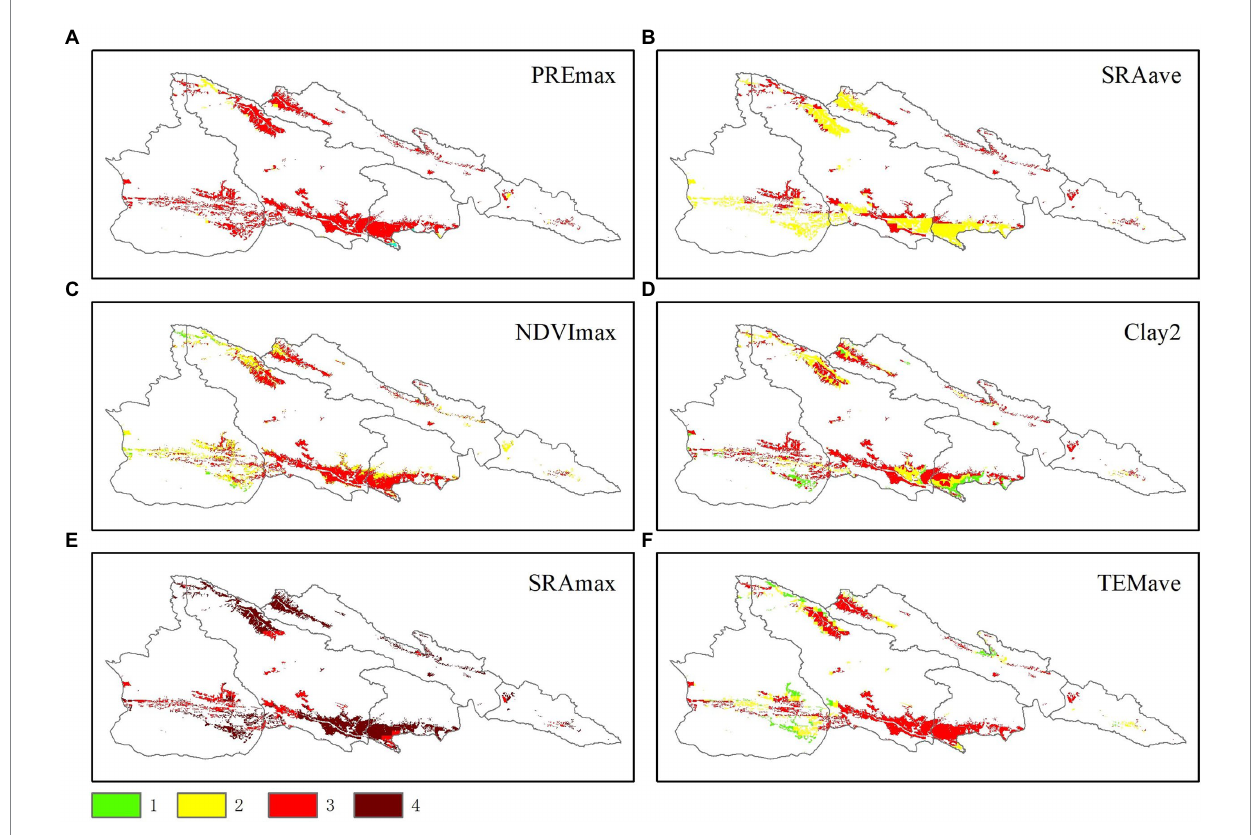
FIGURE 5 Ranking and distribution of the inhabitable indices. The IH of 1, 2, 3, and 4 represent the degree of damage ranged from no damage, mild, moderate, severe, respectively, and the degree of inhabitation are potential area, suitable, more suitable, and very suitable respectively; the density are 25– 60 head/m 2 , 61–96 head/m 2 , 97–132 head/m 2 , 133–168 head/m 2 , respectively, (A-F) refers to the maximum precipitation (PREmax), average solar radiation (SRAave), maximum NDVI (NDVImax), clay concentration of bottom soil (Clay2), maximum solar radiation (SRAmax), and average temperature (TEMave),